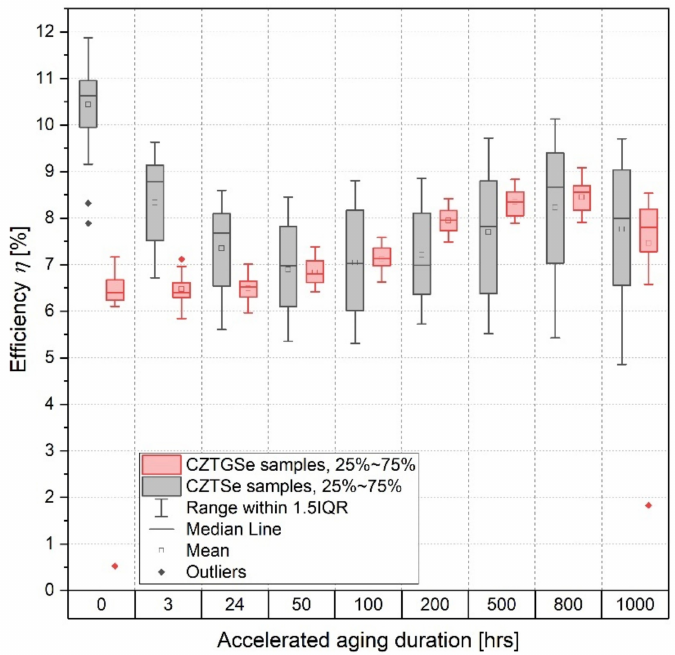
Figure 6. Accelerated aging results for non-encapsulated CZTSe references and CZTGSe solar